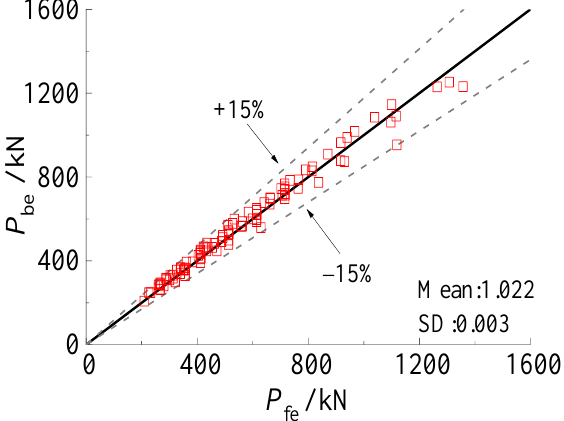
Figure 25. Comparison of ultimate horizontal load between calculated values and numerical values.